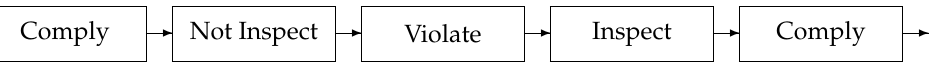
Figure 1. No pure strategy Nash equilibria conventional inspection